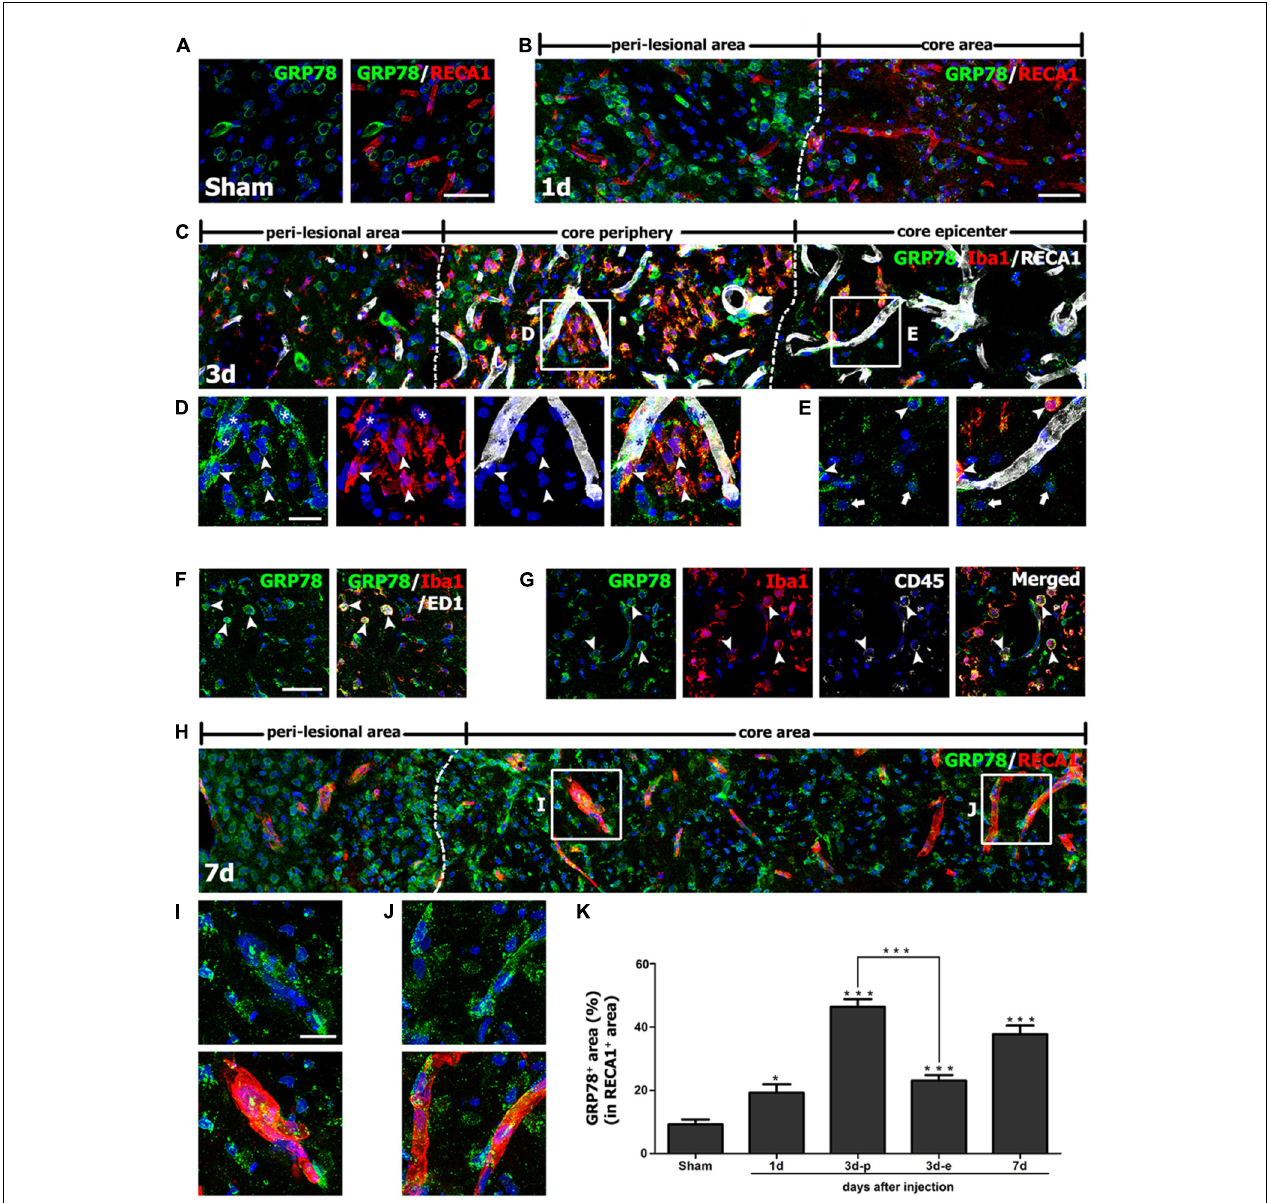
FIGURE 5 | Characterization of glucose-regulated protein (GRP78) expression associated with the vasculature in control and lesioned striata after 3-nitropropionic acid injection. (A) Double-labeling of GRP78 and the endothelial cell marker RECA1 in control striatum, showing that GRP78 immunoreactivity is negligible or absent within vessels. (B) Double-labeling of GRP78 and RECA1 1 day after lesion induction, showing that GRP78 immunoreactivity within vessels is negligible or very weak in the lesion core (right side of the broken line). (C–E) Lower- (C) and higher- (D,E) magnification views of sections triple-labeled for GRP78, Iba1, and RECA1 3 days after lesion induction. The boxed areas of the lesion periphery and the epicenter in C are enlarged in D and E , respectively. Notably, the lesion periphery is heavily infiltrated by GRP78/Iba1 double-labeled microglia/macrophages (arrowheads in D ), while only some Iba1-positive microglia/macrophages can be detected in the epicenter (arrowheads in E ). In addition, GRP78 expression is detectable in association with most of the vasculature (asterisks in D ) in the lesion periphery. Arrows in E indicate presumptive dying or dead neurons that are devoid of significant GRP78 expression. (F,G) Triple-labeling of GRP78, Iba1, and either ED1 or CD45 on day 3 after lesion induction, showing that GRP78 is expressed in nearly all of ED1- (arrowheads in F ) or CD45-positive cells (arrowheads in G ), corresponding to only a small fraction of the GRP78/Iba1 double-labeled cells. Notably, these triple-labeled cells are frequently associated with blood vessels. (H) Double-labeling of GRP78 and RECA1 at 7 days after lesion induction, showing that GRP78 expression is evenly distributed throughout the lesion core (right side of the broken line). (I,J) Higher magnification images of the boxed areas in H , showing that GRP78 immunoreactivity is localized to nearly all vessels in both the lesion periphery (I) and epicenter (J) . (K) Quantitative temporal analysis of the proportion of vascular areas occupied by GRP78 immunoreactivity, within all RECA1-positive vessels. This proportion increases progressively by day 1, and then decreases slightly on day 7. Note that the vascular area covered by GRP78 is significantly higher in the lesion periphery than in the epicenter on day 3. The data are expressed as the mean ± standard error of the mean. ∗ P < 0.05 and ∗∗∗ P < 0.001 vs. saline-treated controls. Cell nuclei are stained with 4 (cid:48) ,6-diamidino-2-phenylindole. Scale bars represent 50 µ m for A–C , F–H ; and 20 µ m for D , E , I , J .